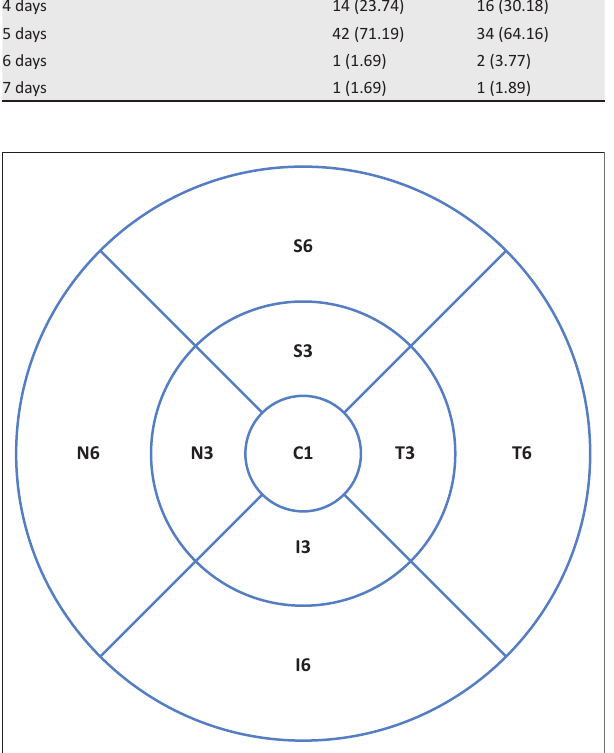
Spearman r = 0.05 p = 0.49